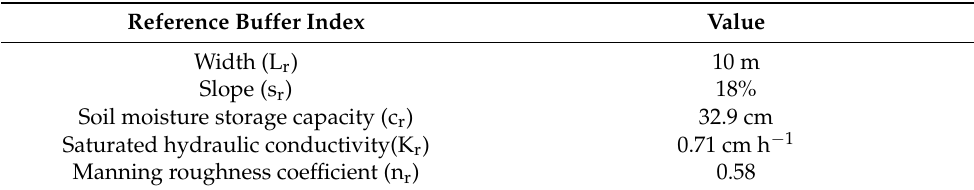
Table 3. Parameters of the reference